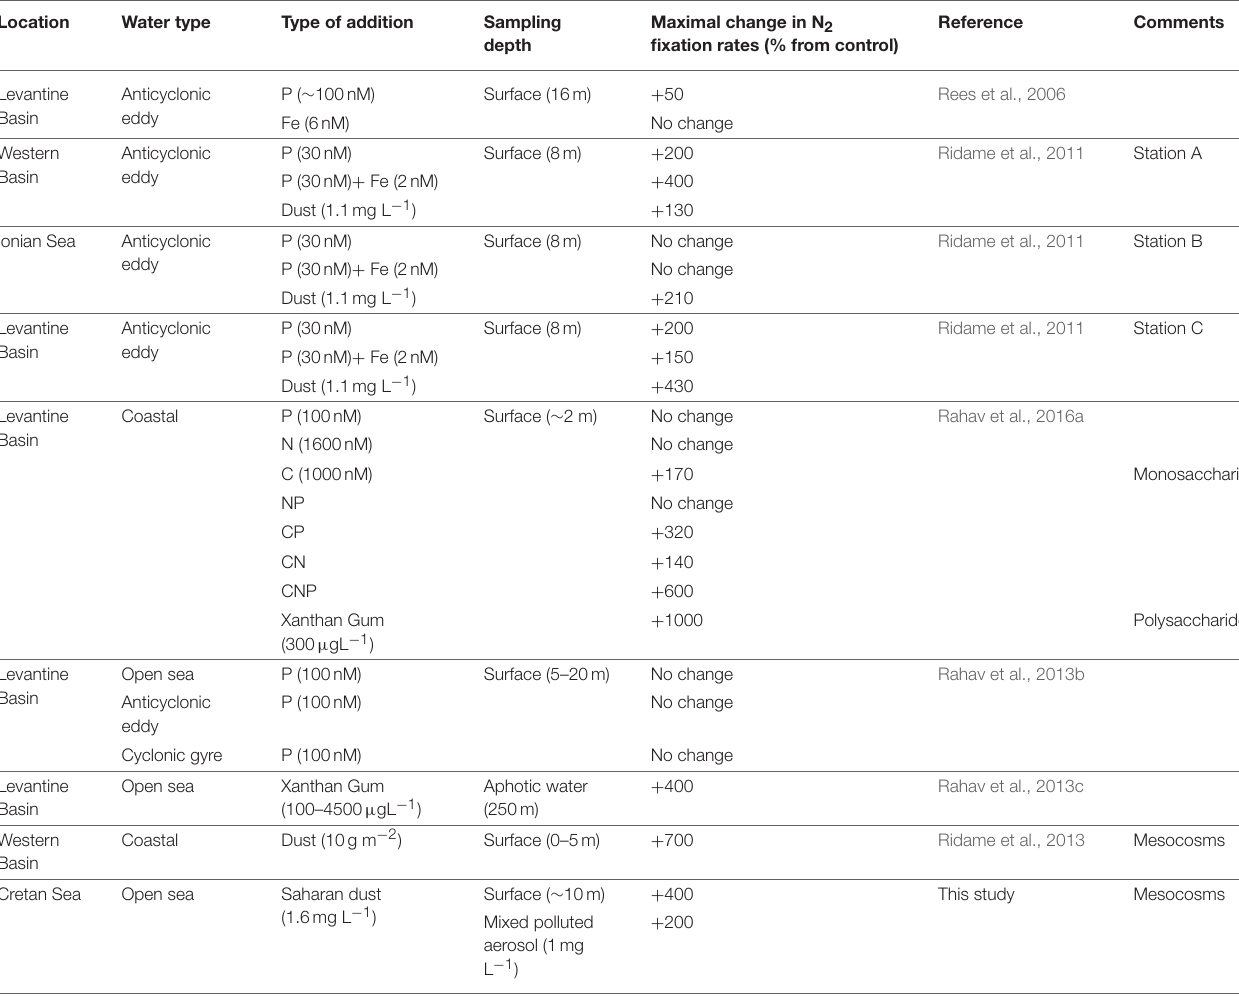
TABLE 1 | Summary of the microcosm/mesocosm experiments performed in the Mediterranean Sea aimed studying the limiting nutrients for diazotrophy.